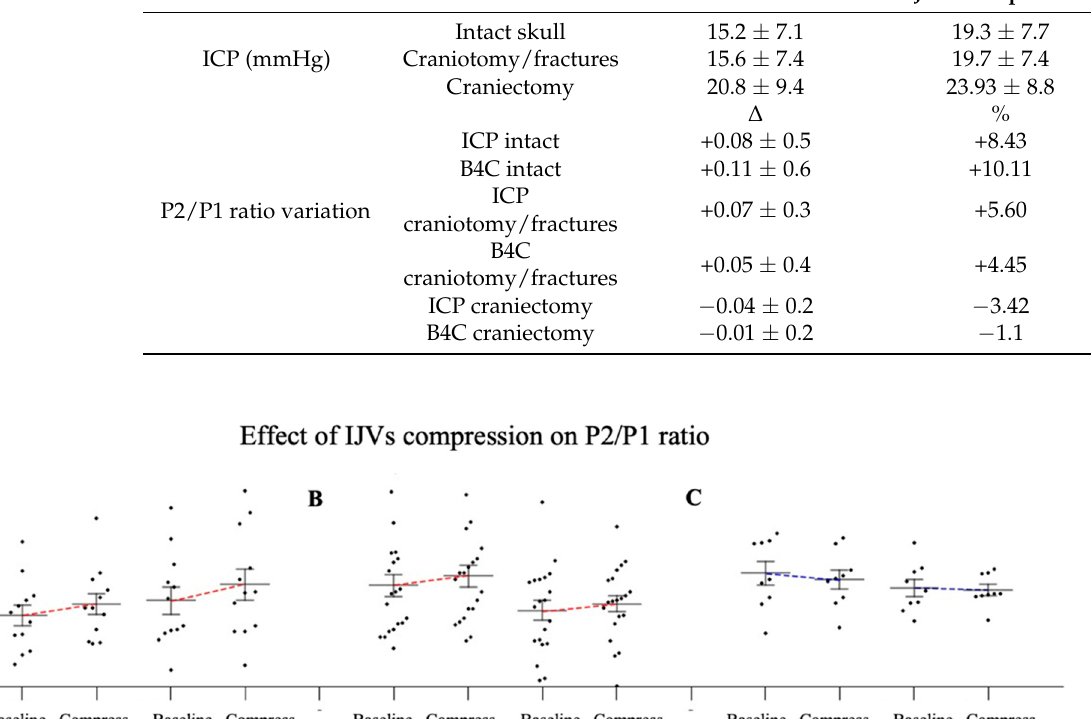
Table 2. ICP and P2/P1 ratio variations with IJVs compression. Mean P2/P1 ratio elevation or